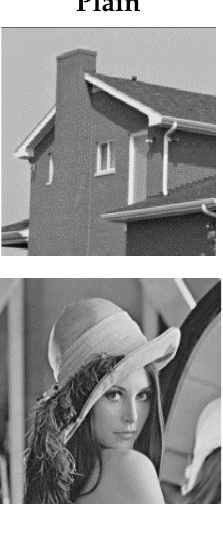
Figure 7. Representation of Histogram for Plain and Cipher